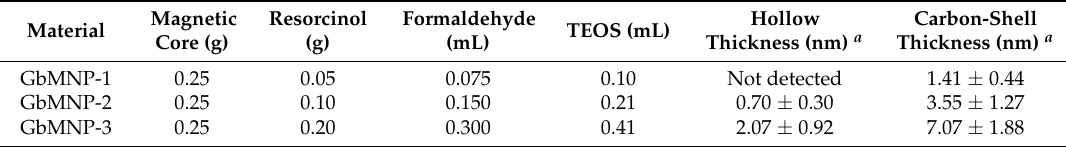
Table 1. The effect of the amount of the precursor resorcinol, formaldehyde, and tetraethyl orthosilicate (TEOS), over the shell and void thicknesses of